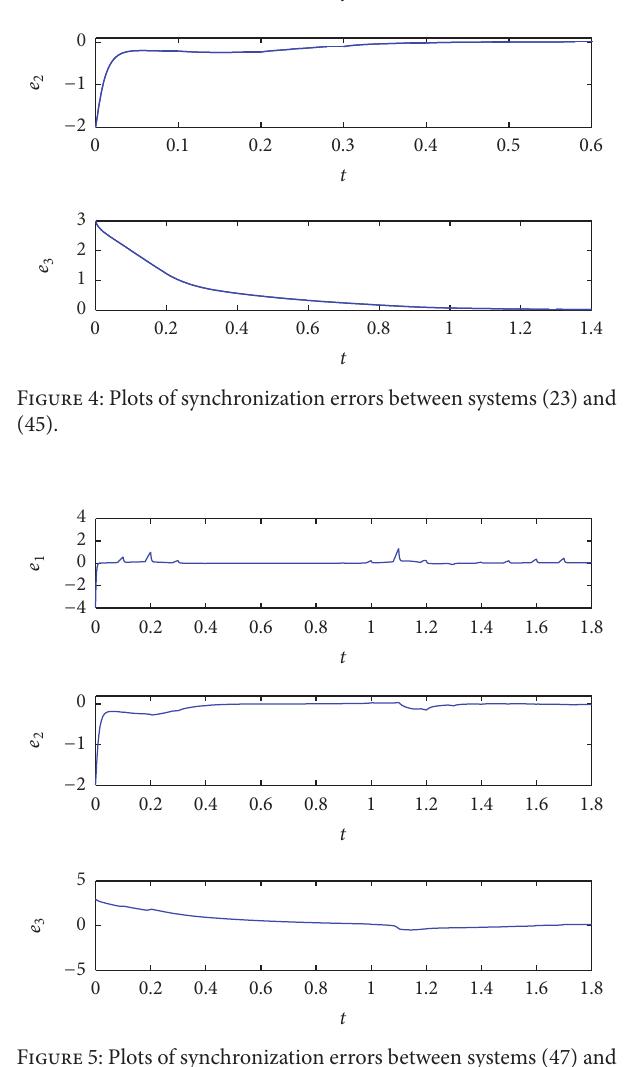
Figure 5: Plots of synchronization errors between systems (47) and